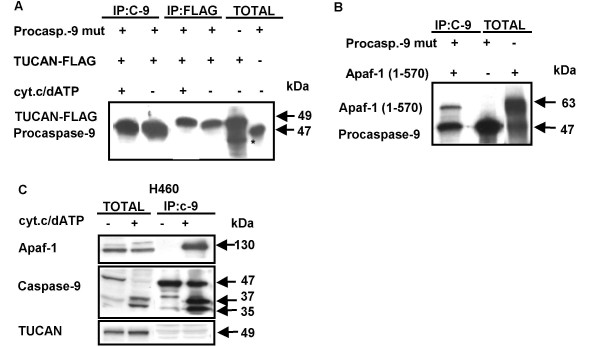
TUCAN does not interact with procaspase-9 or Apaf-1. Immunoprecipitation of in vitro translated procaspase-9 (procaspase-9 mut) mixed with a FLAG-tagged version of TUCAN (TUCAN-FLAG) (A), and procaspase-9 mixed with a truncated variant of Apaf-1 (Apaf-1 (1–570)) as positive control (B). Immunoprecipitation was performed with anti-caspase-9- or anti-Flag antibodies. The total of radiolabelled proteins in the in vitro-translation mixture prior to immunoprecipitation is also included (total). A low molecular weight band obtained in the total TUCAN mixture that did not react with the anti-Flag antibody is indicated with an asterisk. C) H460 cell extract was subjected to caspase-9 pull-down in the presence (+) or absence (-) of exogenously supplied cytochrome c and dATP followed by western blot detection of caspase-9 and TUCAN, or Apaf-1 as positive control. As a control, total cell extract (total) was included.